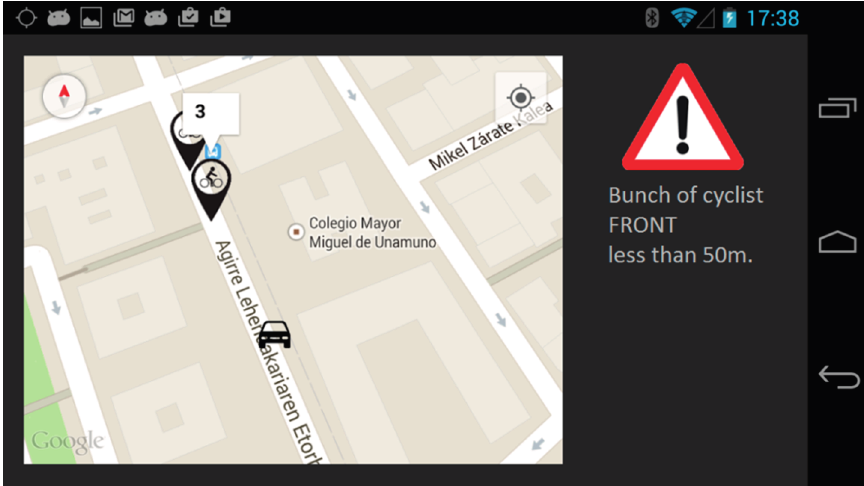
Figure 9. Human Machine Interface onboard the